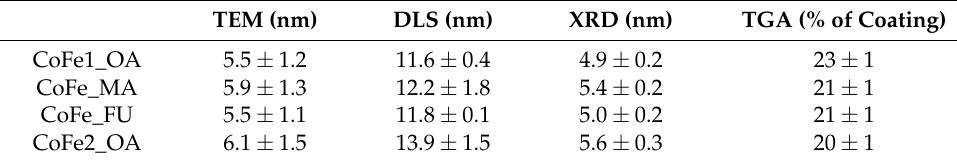
Table 1. Basic properties of the MNPs: particle size (diameter in nm) obtained by TEM, dynamic light scattering method (DLS), and XRD together with the organic content (in percent) revealed by the Thermogravimetric Analysis (TGA).